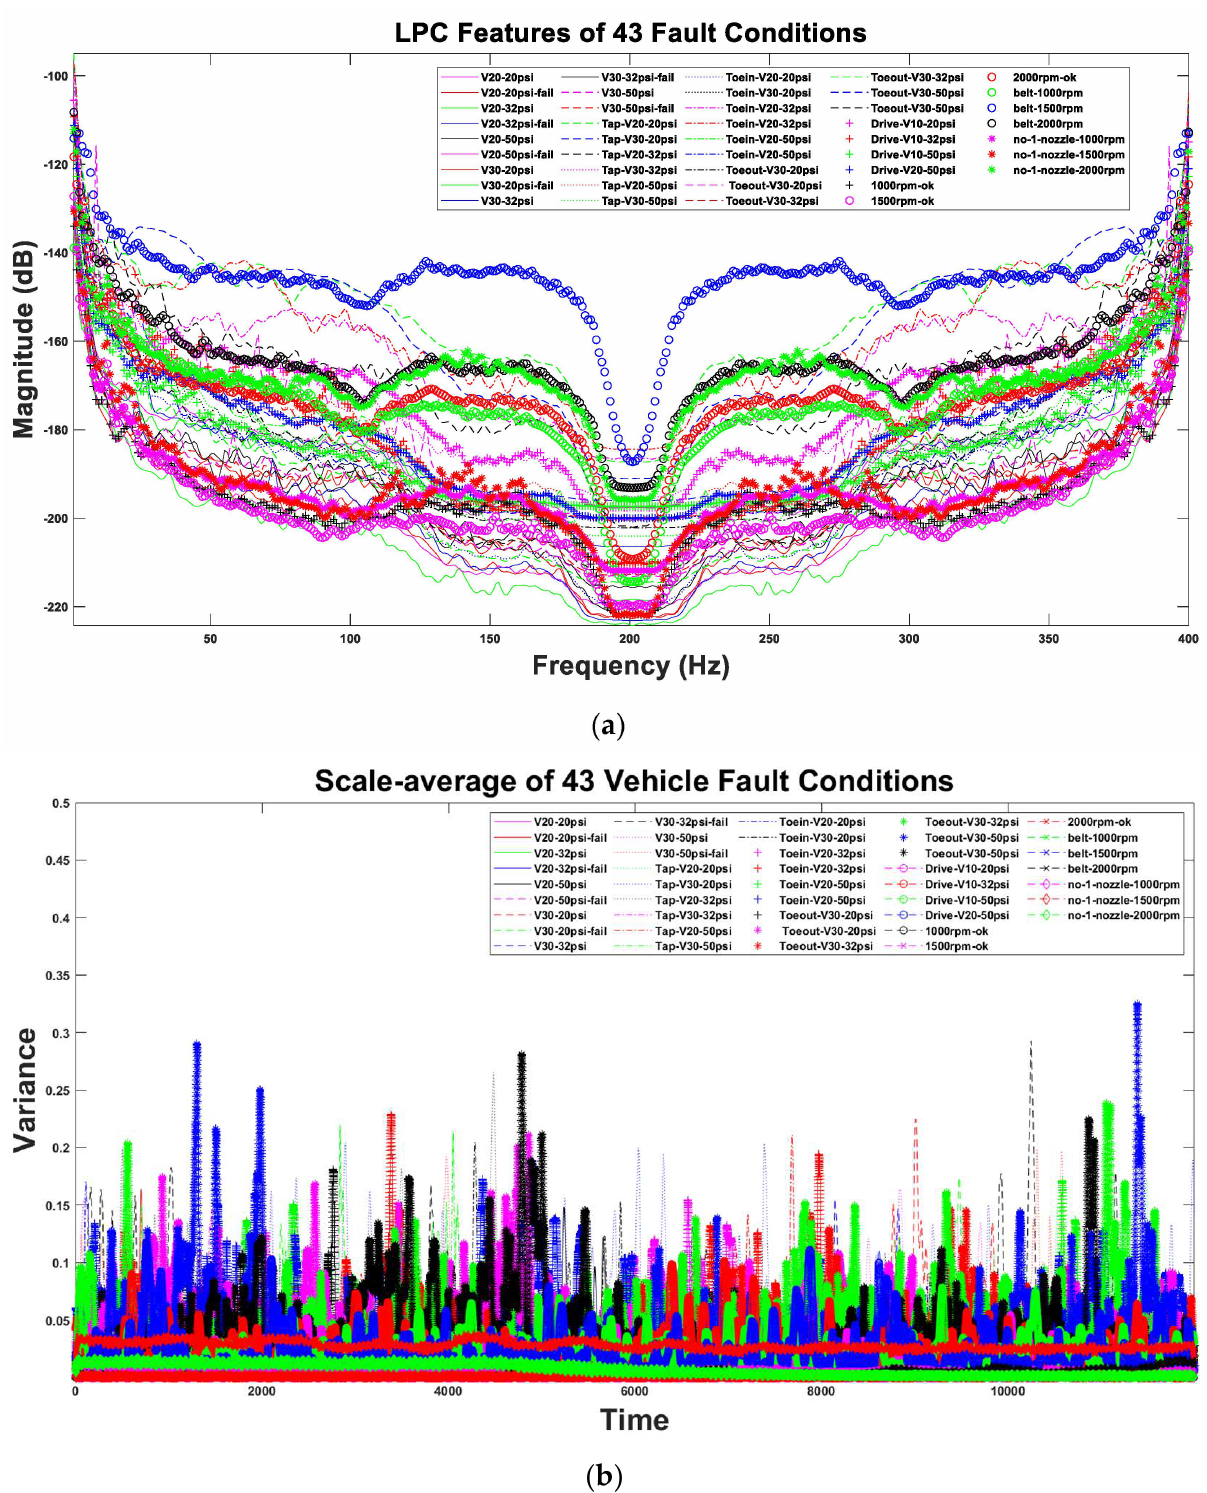
Figure 10. Features of the 43 conditions of the acoustic signals after ( a ) LPC and ( b ) wavelet extrac- tions.